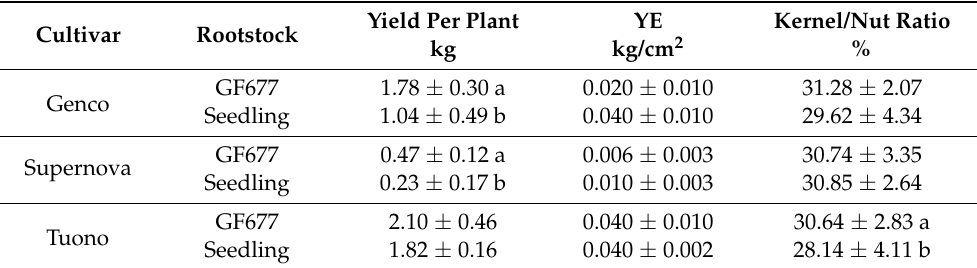
Table 6. Yield per plant, yield efficiency (YE), and kernel/nut ratio recorded for cultivars ‘Genco’, ‘Supernova’ and ‘Tuono’ in the trial A during the growing season 2021. Data are reported as mean ± standard deviation. Different lowercase letters on the columns indicate significant differences between rootstocks (Fisher’s test p <